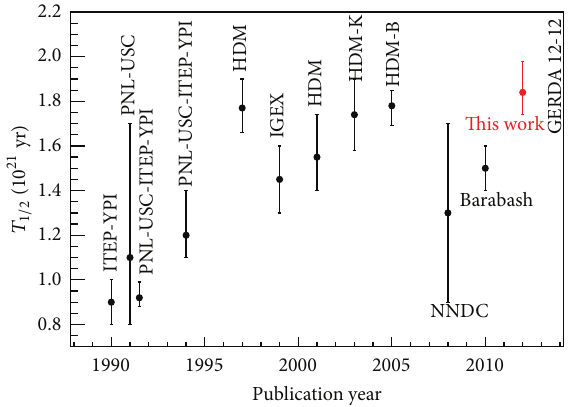
Figure 4: Experimental results for 𝑇 2 ] 1/2 of 76 Ge versus publication year. The plot includes results from the experiments ITEP-YPI [55], PNL-USC [56], PNL-USC-ITEP-YPI [57, 58], Heildelberg-Moscow (HdM) [15, 59], and Igex [17, 18] as well as reanalysis of the HdM data by D¨orr and Klapdor-Kleingrothaus [60] (HdM-K) and by Bakalyarov et al. [61] (HdM-B). Recommended values coming from a global analysis are also shown (NNDC [62], Barabash [2]). From